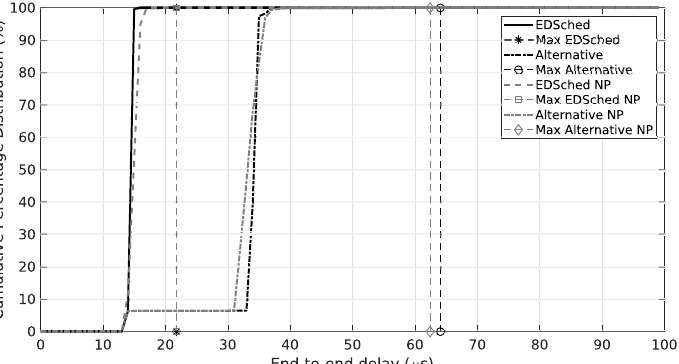
Figure 7. CaseC-Event-drivendelaycumulativepercentagedistributionwithandwithout(NP)